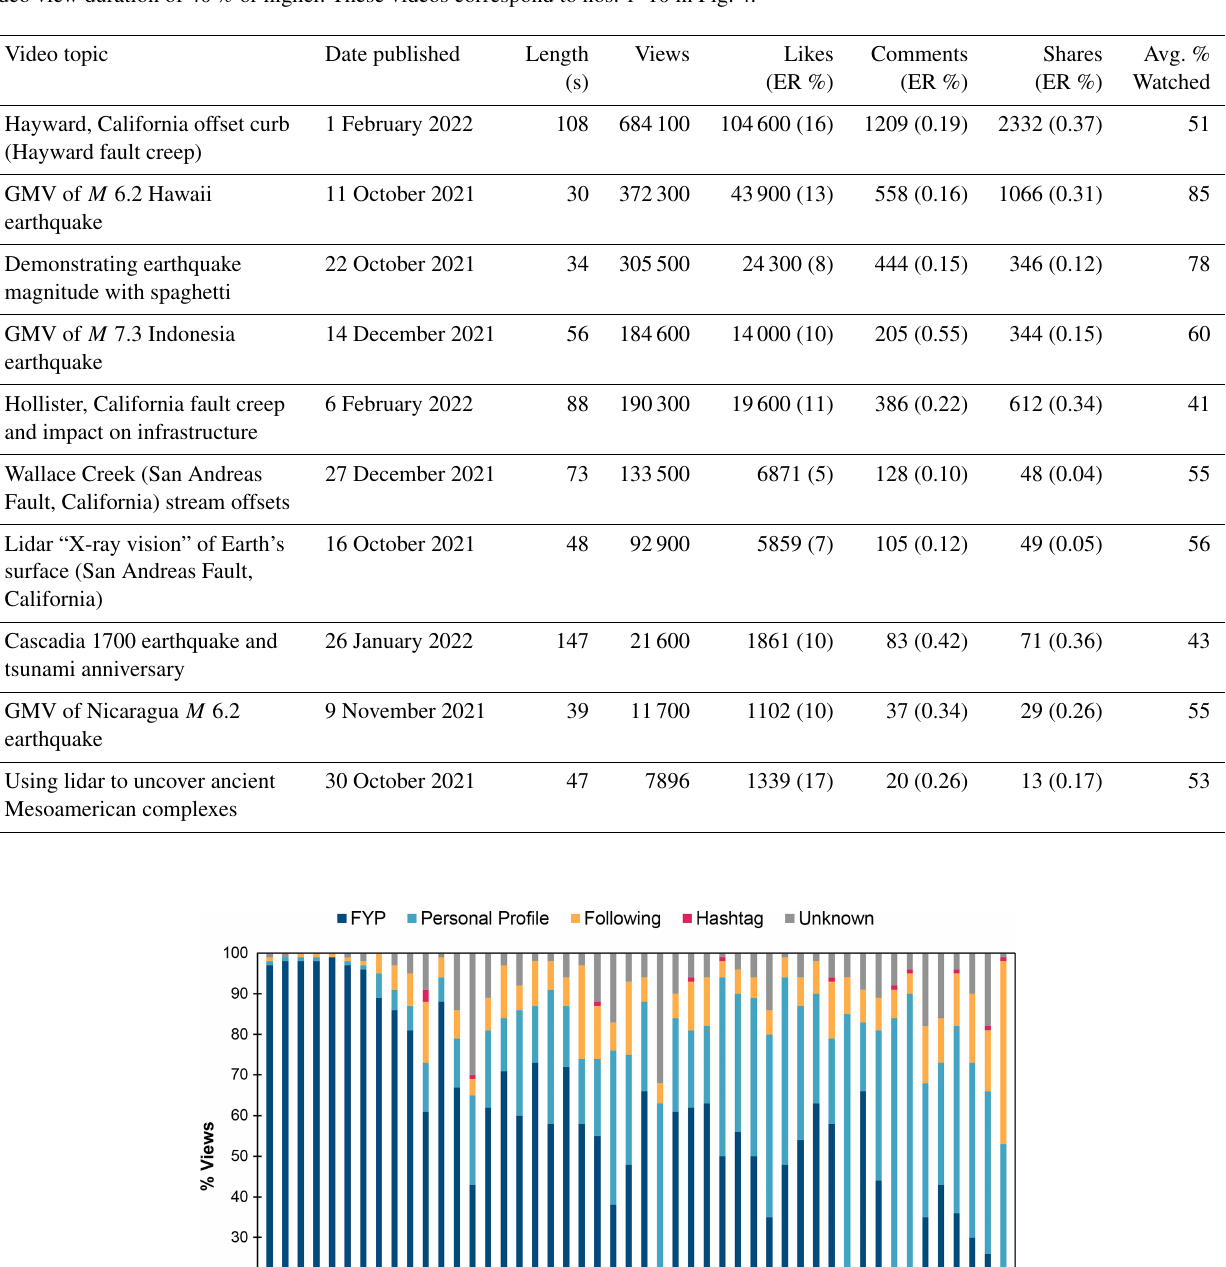
Table 2. Top 10 most-viewed videos between 8 October 2021 and 6 February 2022 on the Terra Explore and corresponding metrics. GMV: ground motion visualization, M : earthquake magnitude. ER %: engagement rate (metric / audience reached × 100). All videos had an average video view duration of 40% or higher. These videos correspond to nos. 1–10 in Fig. 4.